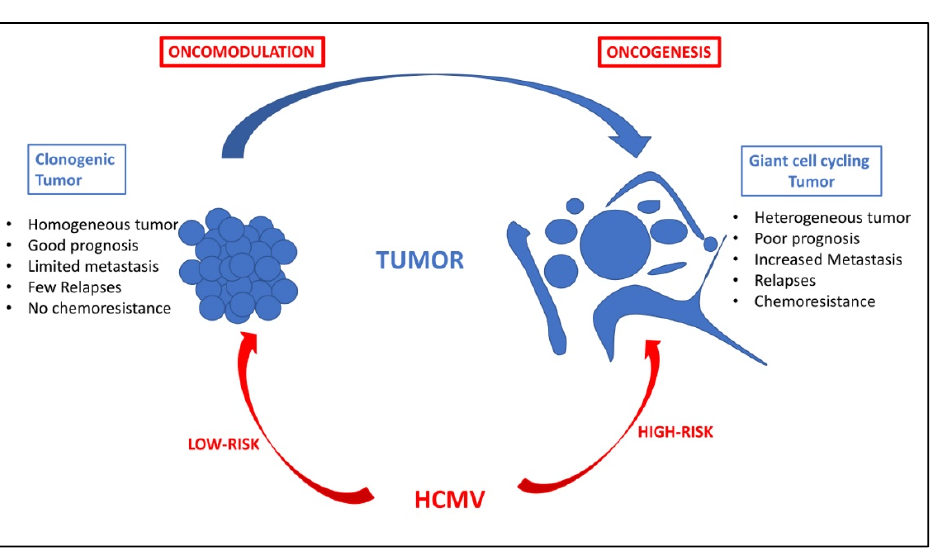
Figure 2. HCMV oncomodulation and oncogenesis: two paradigms for one tumor. Oncomodulation will result from the infection of tumor cells by HCMV strains (named low-risk strains), which will enhance the clonogenic development of the tumor and result in a tumor with quite controlled cell homogeneity, limited metastasis, few relapses, sensitivity to chemotherapy and radiotherapy, and an overall of good prognosis. In contrast, direct oncogenesis will result from the infection of primary cells by HCMV strains (named high-risk strains), which could participate in giant cell cycling with the appearance of polyploid giant cancer cells (PGCCs), in a tumor with highly heterogeneous cancer cells, increased risk of metastasis, more relapses, chemoresistance, and, ultimately, poor prognosis. Of note, the two paradigms, oncomodulation versus oncogenesis, might not be mutually exclusive but could coexist in the same patient depending on the fitness of the HCMV strain, which might vary over time.